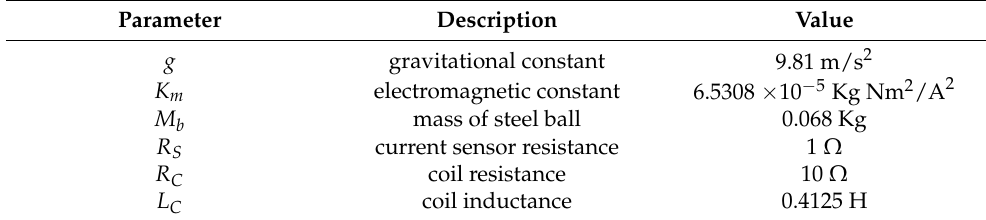
Table 1. Simulation parameters of